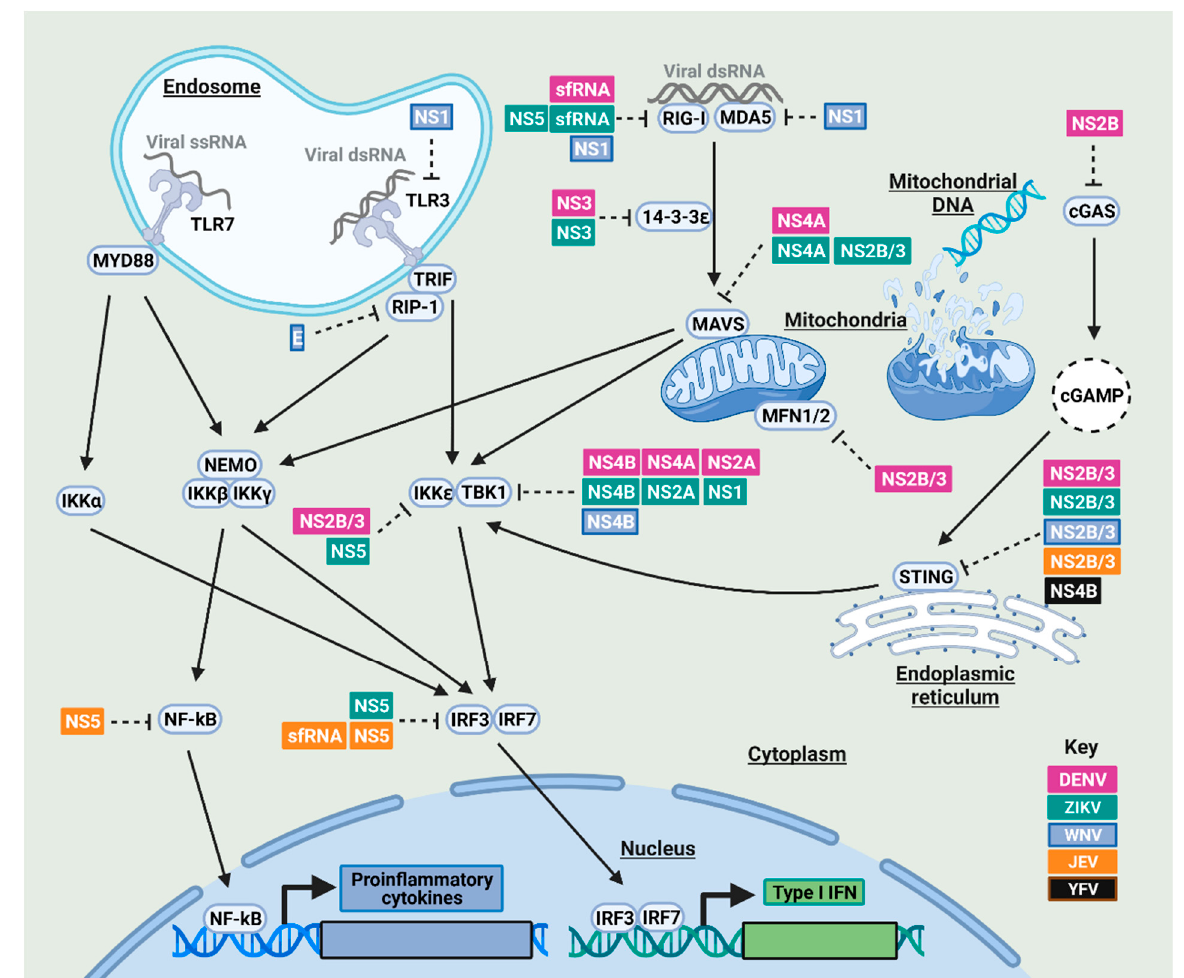
Figure 1. NF- κ B and IRF signaling in response to mosquito-borne flavivirus infection and their antagonism in